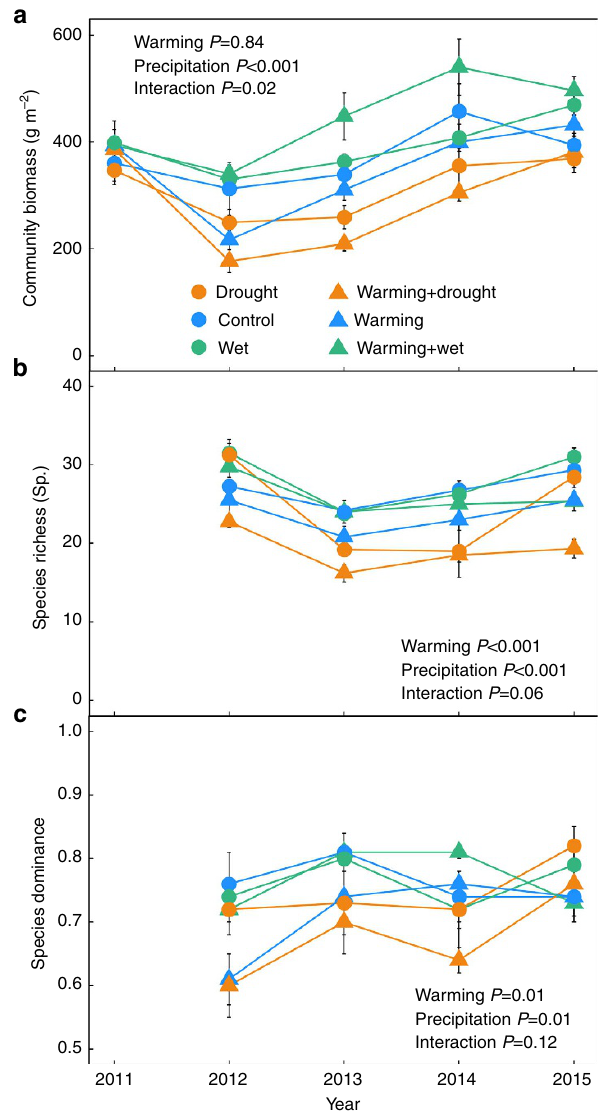
Figure 1 | Community biomass and species diversity in different experimental treatments. Shown are ( a ) community biomass (linear mixed-effects model; warming: P ¼ 0.84; precipitation: P o 0.001; interaction: P ¼ 0.02); ( b ) species richness (linear mixed-effects model; warming: P o 0.001; precipitation: P o 0.001; interaction: P ¼ 0.06); and ( c ) Simpson’s dominance (linear mixed-effects model; warming: P ¼ 0.01; precipitation: P ¼ 0.01; interaction: P ¼ 0.12) in the warming and altered precipitation treatments during the experimental period. Drought, 50% reduction in precipitation compared with control; Wet, 50% increase in precipitation compared with control. Vertical bars represent the